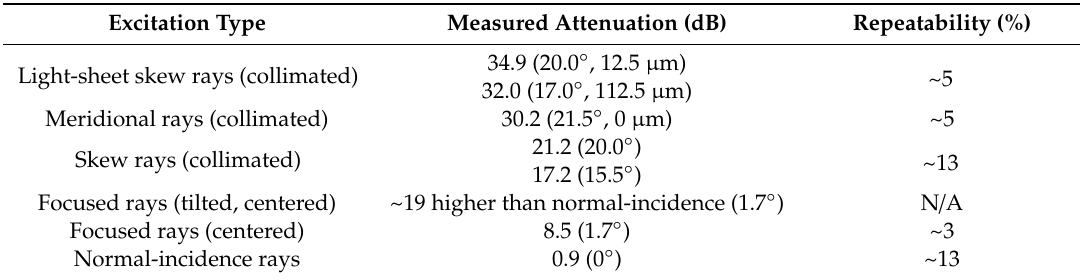
Table 1. Comparison of di ff erent excitation types. Repeatability is the percentage error. © 2019 IEEE. Reprinted, with permission, from [63].